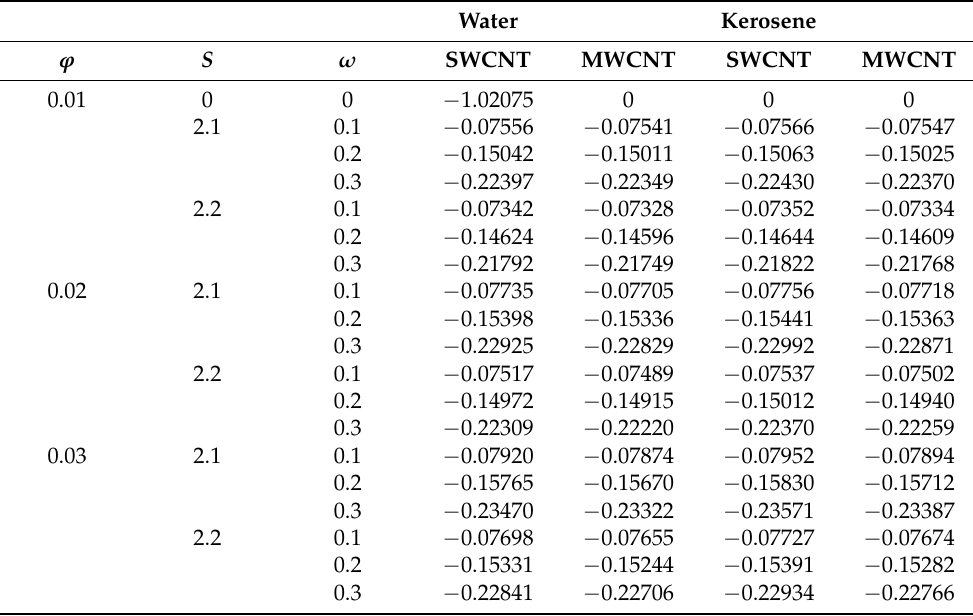
Table 4. Values of Re 1/2 x C fy for different values of ϕ , S , and ω when ε = 1.0 (stretching case) for both water and kerosene base fluids.